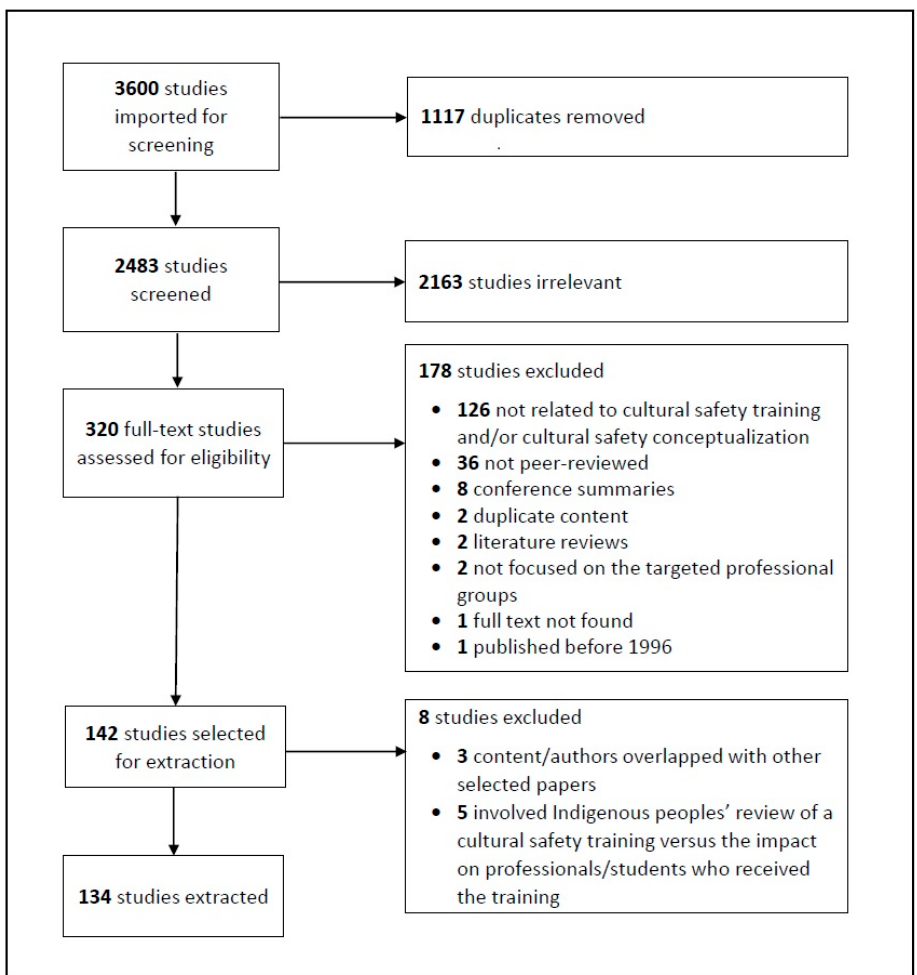
Figure 1. Prisma Flow Diagram.